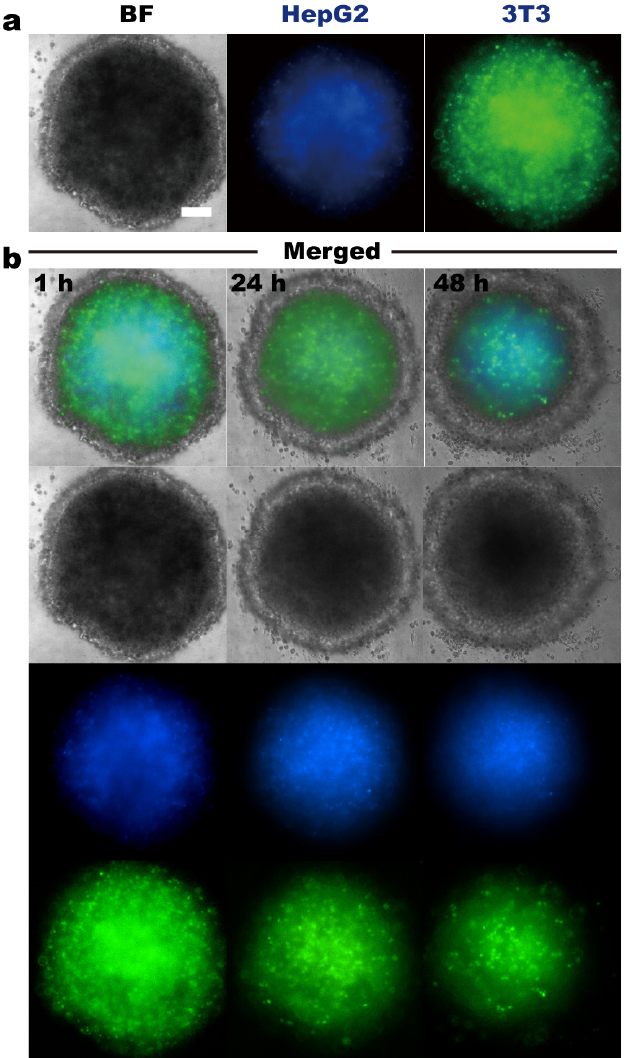
Figure 5. Culture of tumor spheroid formed by self-organization of 3T3 and HepG2 cells. ( a ). Live- cell images of tumor spheroid; nucleus of HepG2 cells was stained by DAPI, and 3T3 fibroblasts by H2B-FITC. ( b ). Conformational changes in tumor spheroid during 48 h culture on the chip. Scale bar denotes 100 μ m.